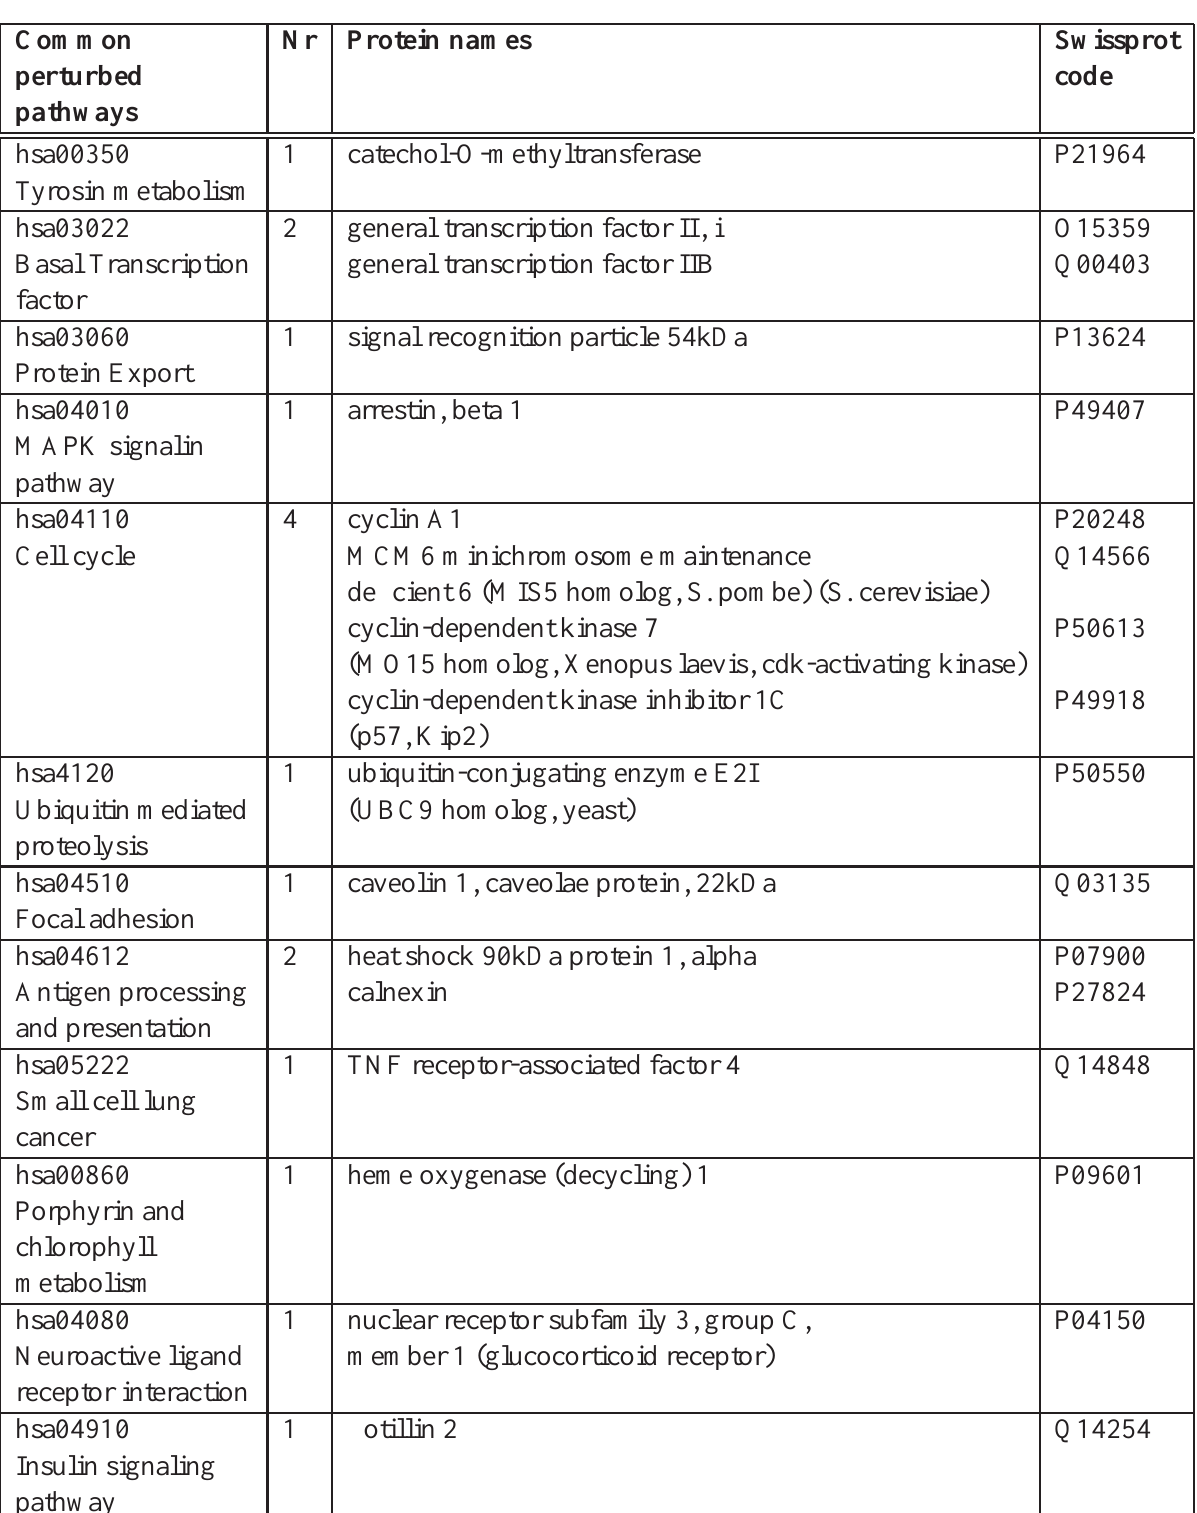
Table 2: The table gives an outline of the names and of the Swissprot codes of the proteins, screened by Abs-array, involved in the common KEGG functional